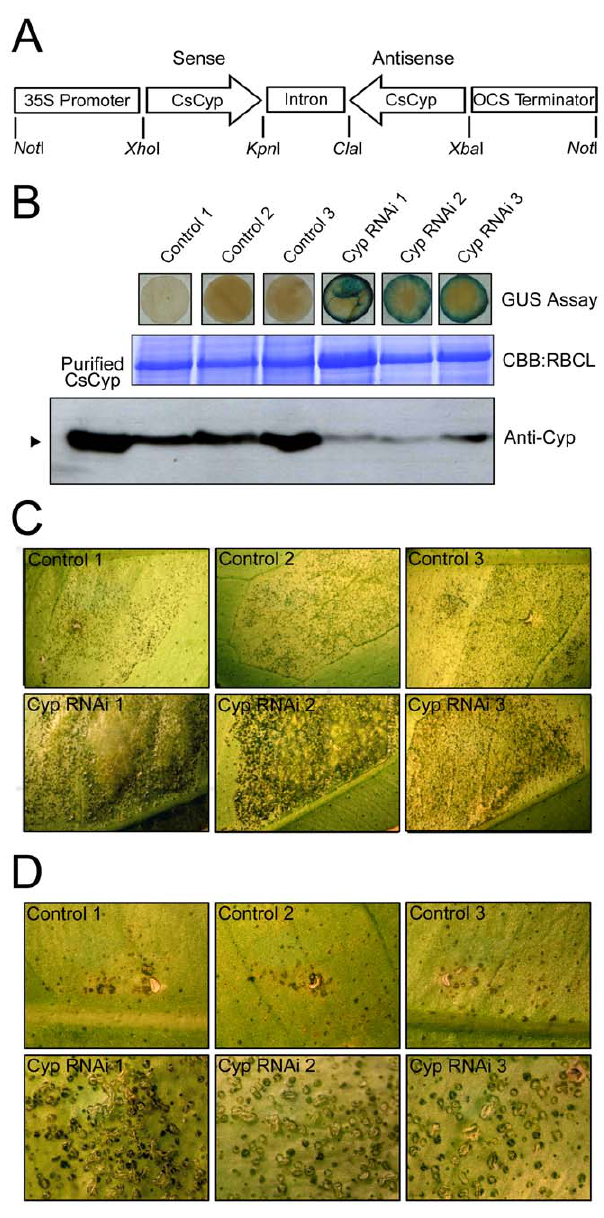
Figure 7. Silencing of CsCyp enhanced canker symptoms. (A) Schematic representation of the RNAi hairpin construct used to transform sweet orange plants. The construct carries the whole cyclophilin domain of CsCyp in an inverted orientation and separated by the intron of the pHANNIBAL vector. (B) Transgenic plants carrying the CsCyp RNAi hairpin construct were assayed for GUS activity and analyzed by western blot using the anti-CsCyp serum (Anti-Cyp). Examples of CsCyp RNAi plants (GUS positive) showing significantly lower levels of CsCyp relative to untransformed controls are shown. Protein loads were controlled by Coomassie Brilliant Blue (CBB) staining of the bands corresponding to the large subunit of Ribulose-1,5- bisphosphate Carboxylase (RBCL). Recombinant CsCyp with no tags was loaded in the first lane of the blot as a positive control. (C) Sweet orange leaves of control and three RNAi plants (Cyp RNAi) challenged with X. citri (approximately 2.0 6 10 4 cells). Pictures (10 6 magnifications) were taken 14 days after bacterial infiltration. Canker lesions were substantially enhanced in the RNAi plants compared to controls. (D) Sweet orange leaves of control and RNAi plants infiltrated with X. citri at a lower density (approximately 10 3 cells). Canker pustules in the RNAi plants developed much faster and produced more rupture of the